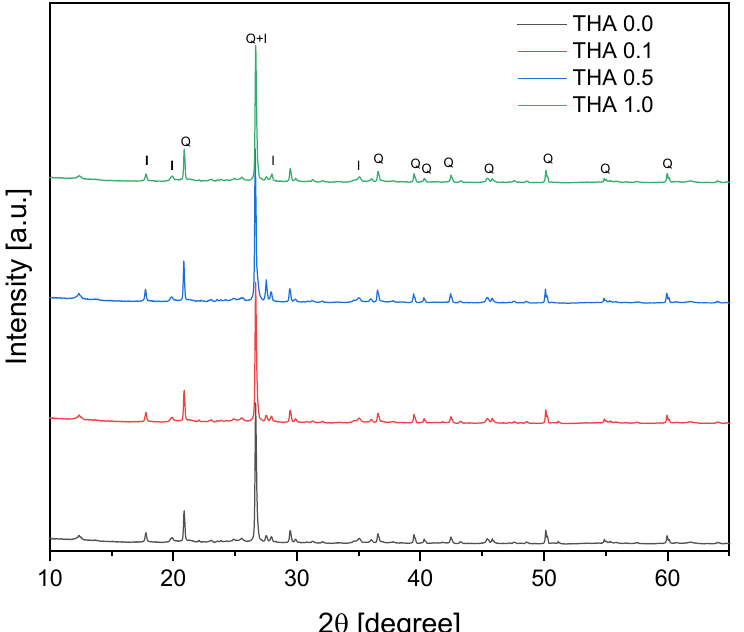
Figure 2. XRD patterns of illite samples.